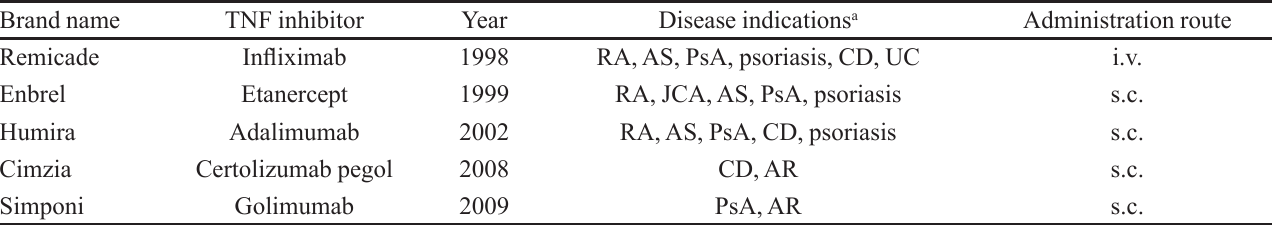
TABLE I - TNF inhibitors licensed for clinical use Brand